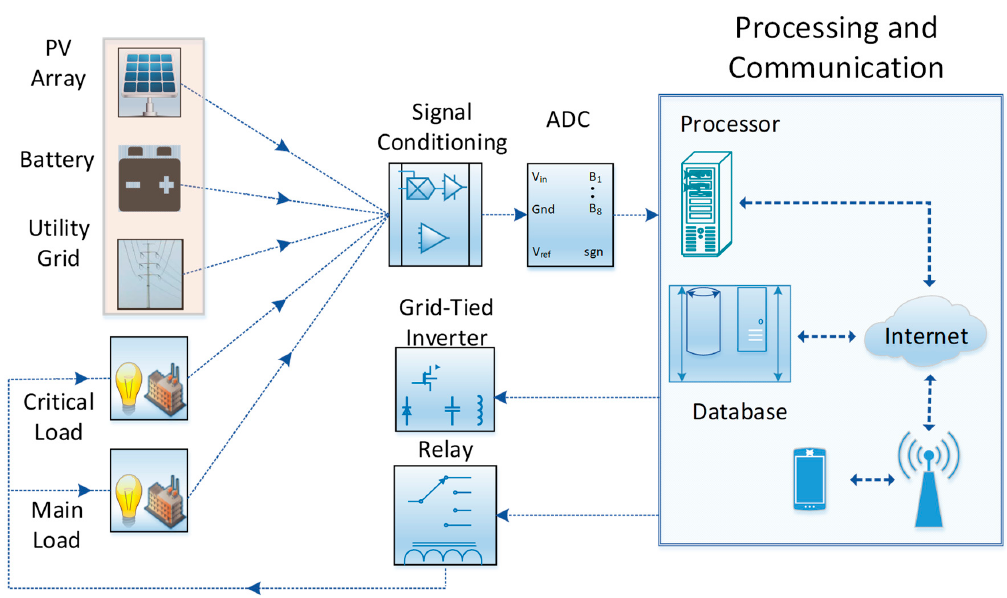
Figure 3. Block diagram showing communication between processor various power sources and controlling of the relay.